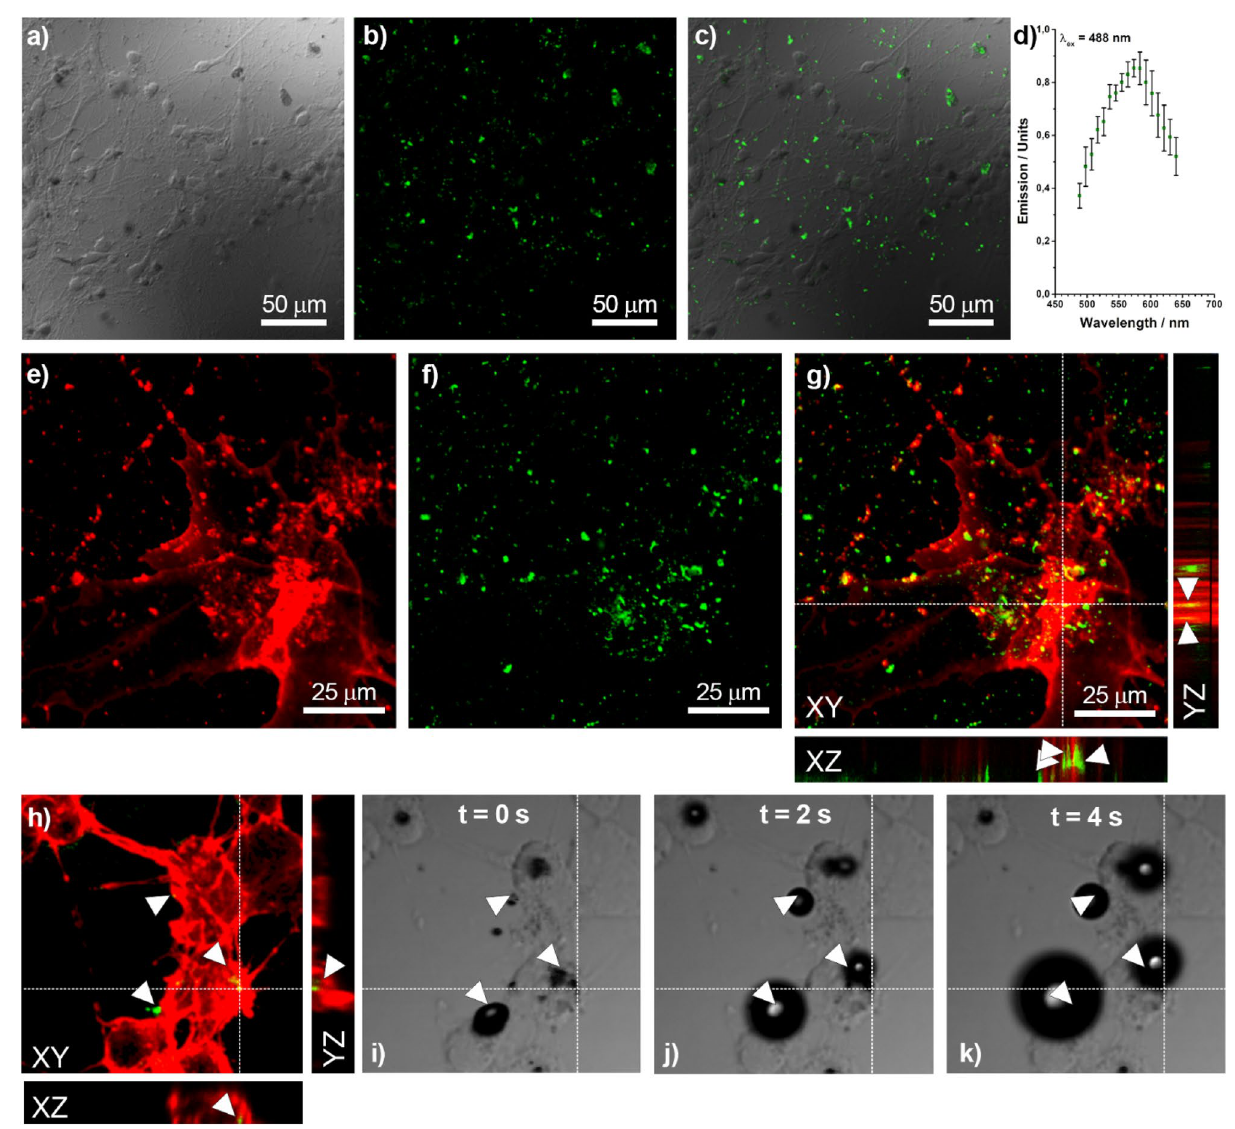
Figure 5. Imaging at confocal microscope of primary cultures of murine cortical neurons and astrocytes incubated with a-DG-AuNPs (700 µg/mL) for 4 h. Identification of DG-AuNPs and fluorescence : ( a ) DIC image (×40); ( b ) fluorescence image of AuNPs (λ ex = 488 nm); ( c ) merging of the images a and b showing the correspondence between the nanoparticle location and green fluorescence; ( d ) emission spectrum of AuNPs (λ ex = 488 nm). Internalization in cell of DG-AuNPs : ( e ) fluorescence image of astrocytes with rhodamine-stained F-actin (red); ( f ) fluorescence image of AuNPs (λ ex = 488 nm); ( g ) merging of images d and e , with Z-stacking lateral views showing the internalization of the AuNPs in the cell. Cell photoablation: ( h ) fluorescence image of neuron with rhodamine stained F-actin; ( i – k ) DIC images upon laser-pulsed excitation tuned at wavelength of 760 nm and power of 24 W/cm 2 showing the rapid formation of bubbles in correspondence of